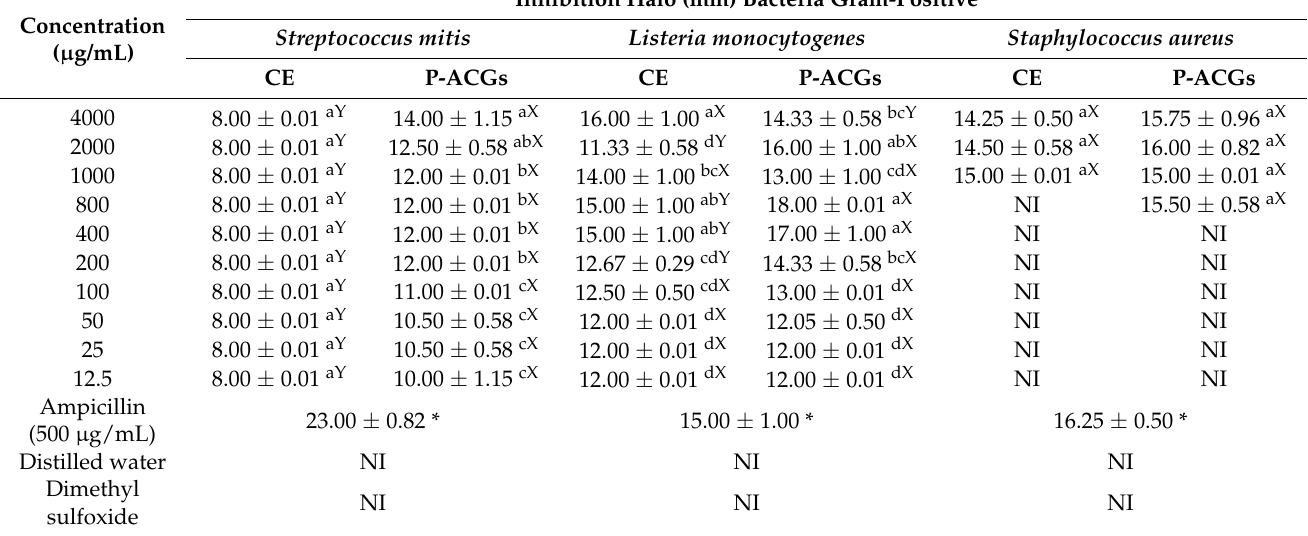
Table 1. Antibacterial activity of the crude extract (CE) and purified acetogenins (P-ACGs) from the endosperm of A. muricata seeds against several Gram-positive